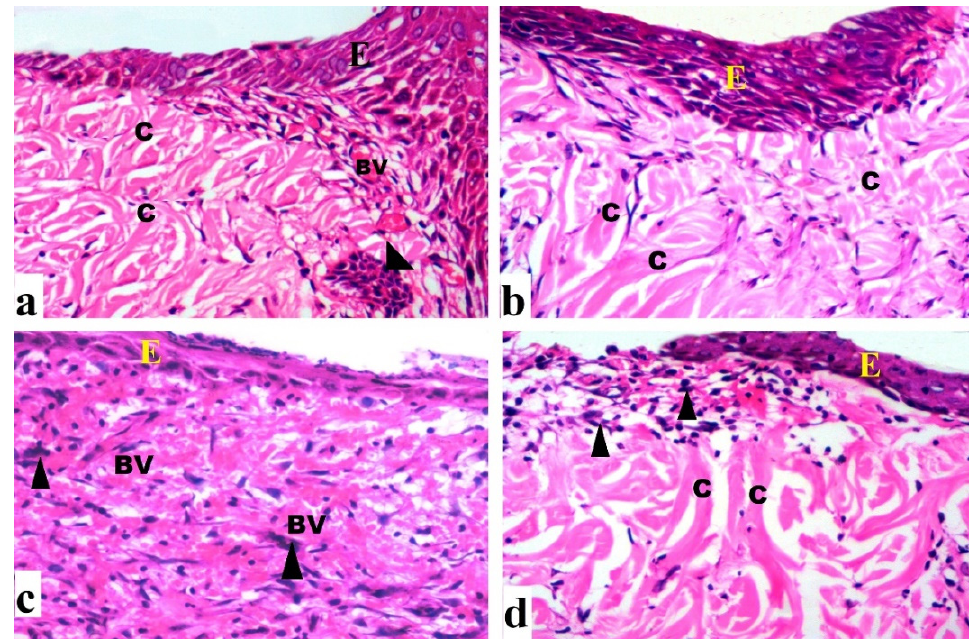
Figure 8. Sections were taken from a skin wound on day 14 ( a ) An untreated wound indicating aggregation of inflammatory cells (arrowhead), collagen fibers (C) that are regular, partial re-epithelialization (E), and blood capillaries (BV). ( b ) DEEL-treated wound with newly formed capillaries, increased fibroblast proliferation, dense regular collagen fibers, and re-epithelialization. ( c ) An MRSA-infected wound displaying poor granulation, numerous inflammatory cells, few fibers, and little re-epithelialization. ( d ) The wound infected with MRSA and treated with DEEL had an incomplete thin regenerated epidermis and collagen fibers (H&E X200).